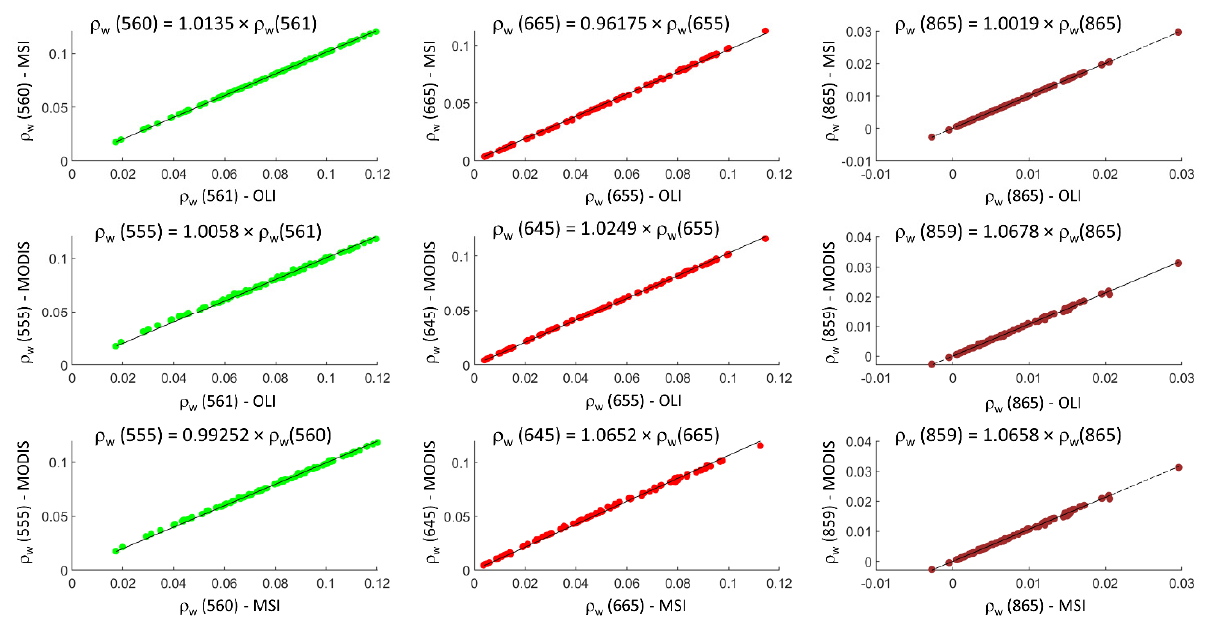
Figure A8. Water-leaving reflectance matchups obtained between the MODIS 250 m resolution green (555 nm), red (645 nm), and NIR (859 nm) bands and the in situ water-leaving reflectance data acquired in the river plume during sea campaigns.